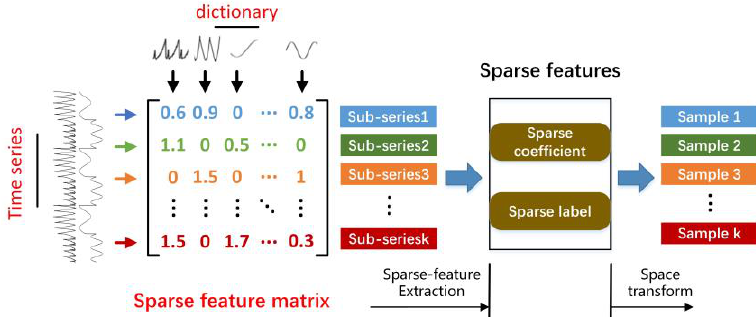
Figure 3. Semantic graph of sparse feature space.